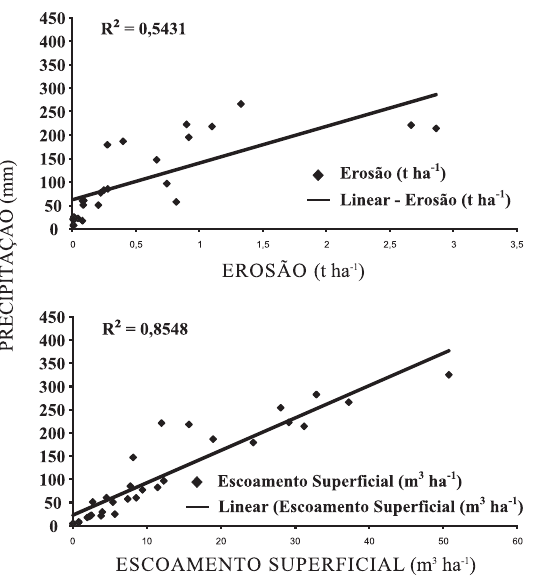
Figura 5. Relação entre as precipitações, perdas de solo e escoamento superficial no tratamento sob pousio